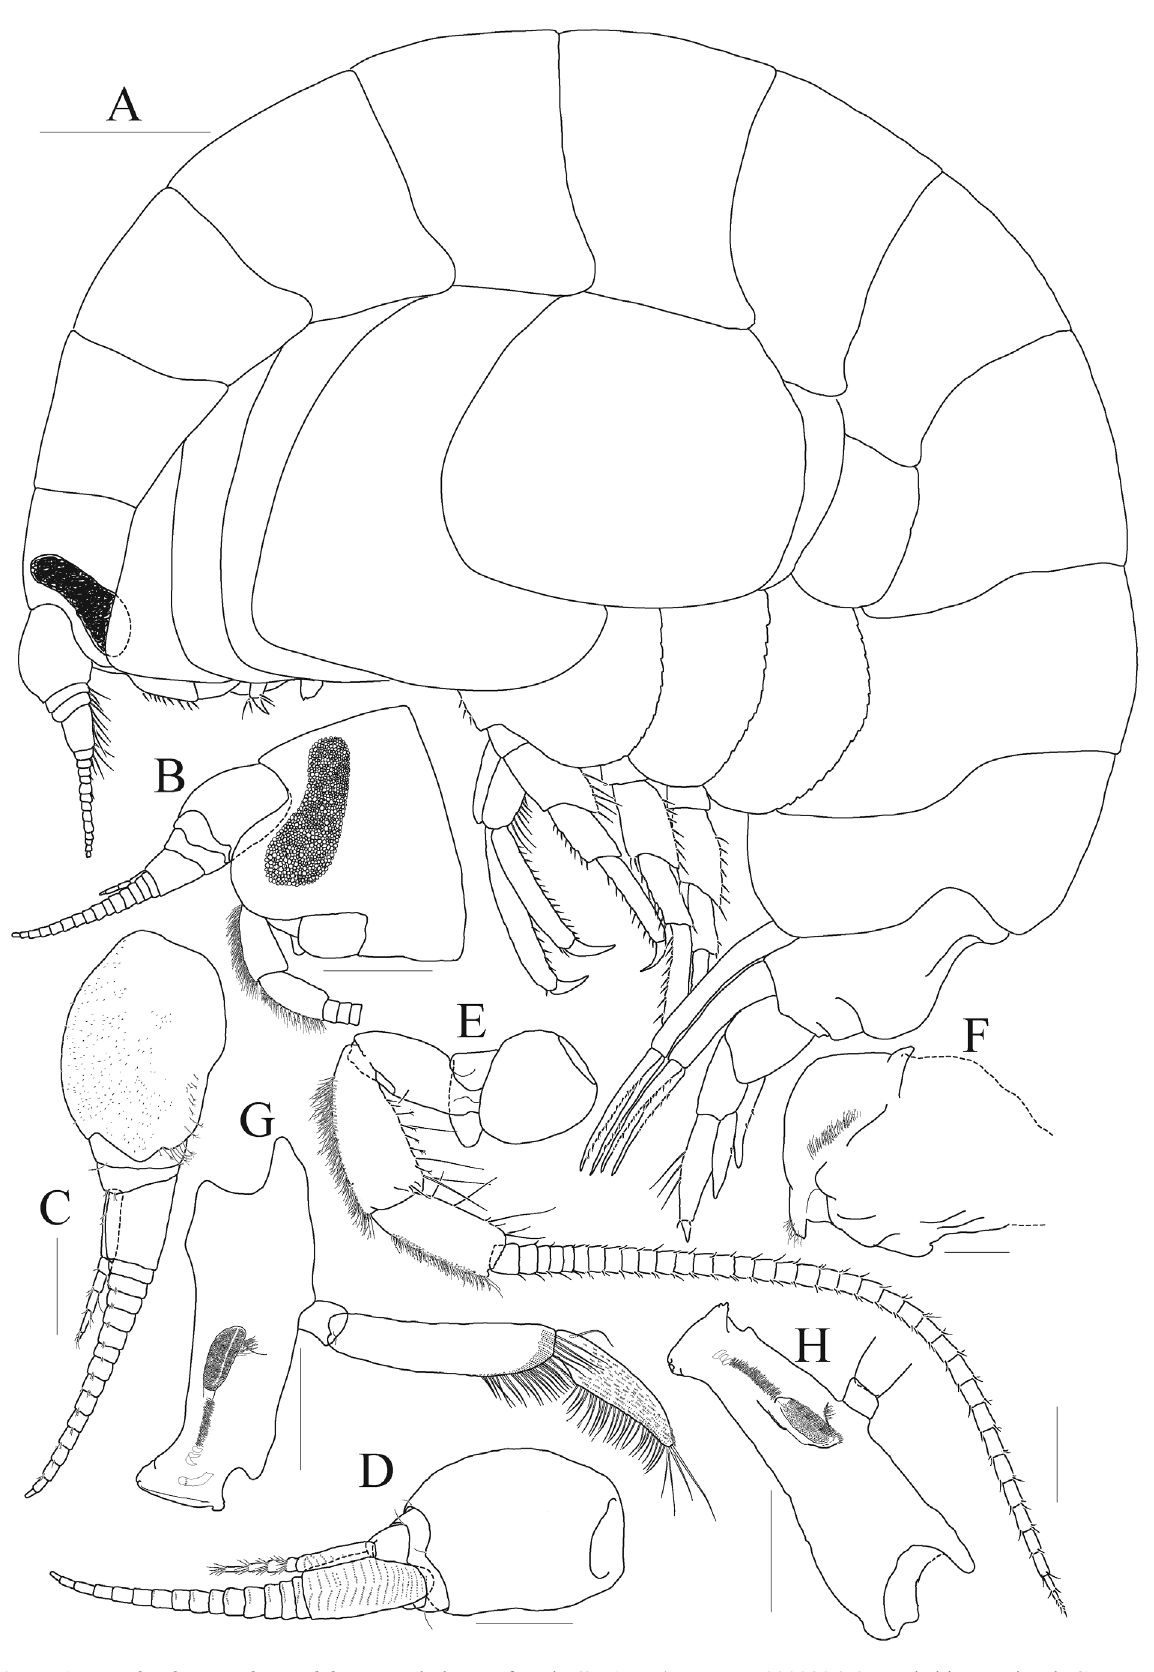
Figure 1. Pseudorchomene boreoplebs sp. n., holotype female (27.1 mm), NIBRIV0000806535. A habitus; B head; C antenna 1, lateral; D antenna 1, medial; E antenna 2; F upper lip, lateral; G left mandible; H right mandible. Scale bars 0.2 mm ( F ), 0.5 mm ( C–E, G, H ), 1.0 mm ( B ), 2.0 mm ( A